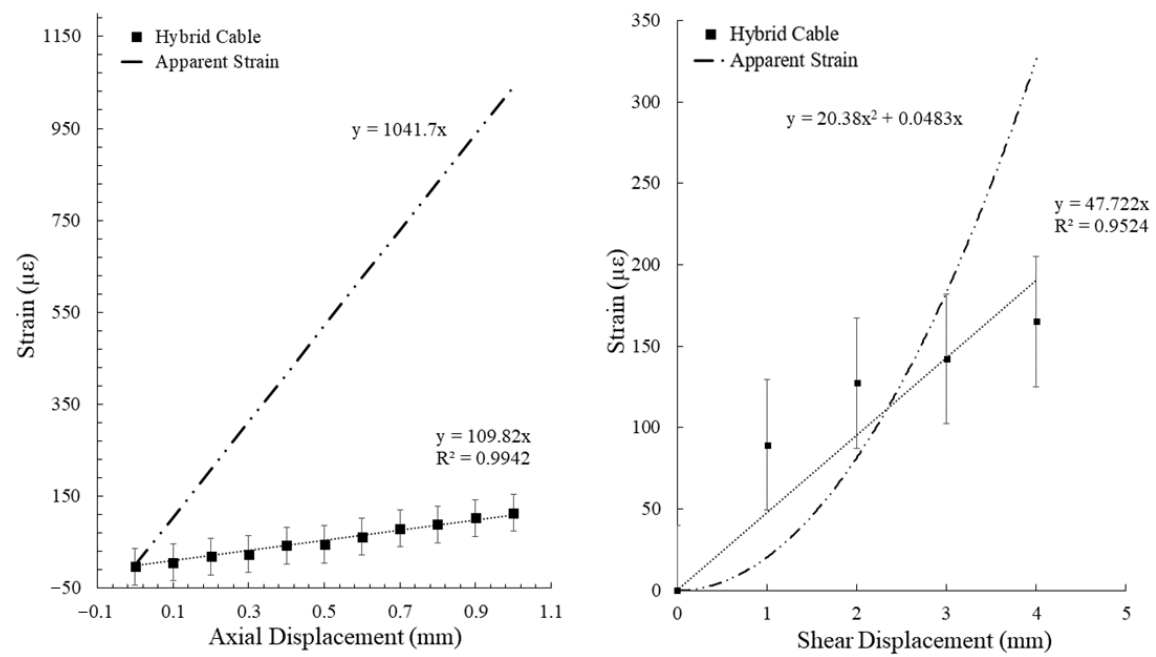
Figure 21. Apparent strain and measured strain when using the hybrid fiber optic cable in the tensile deformation experiment ( left ) and shear deformation experiment ( right ). deformation experiment ( left ) and shear deformation experiment ( right